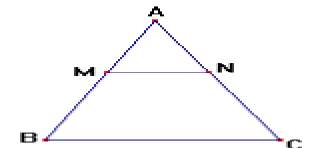
Fig. 5. Enoncé de Thalès dans le manuel de 2 ème